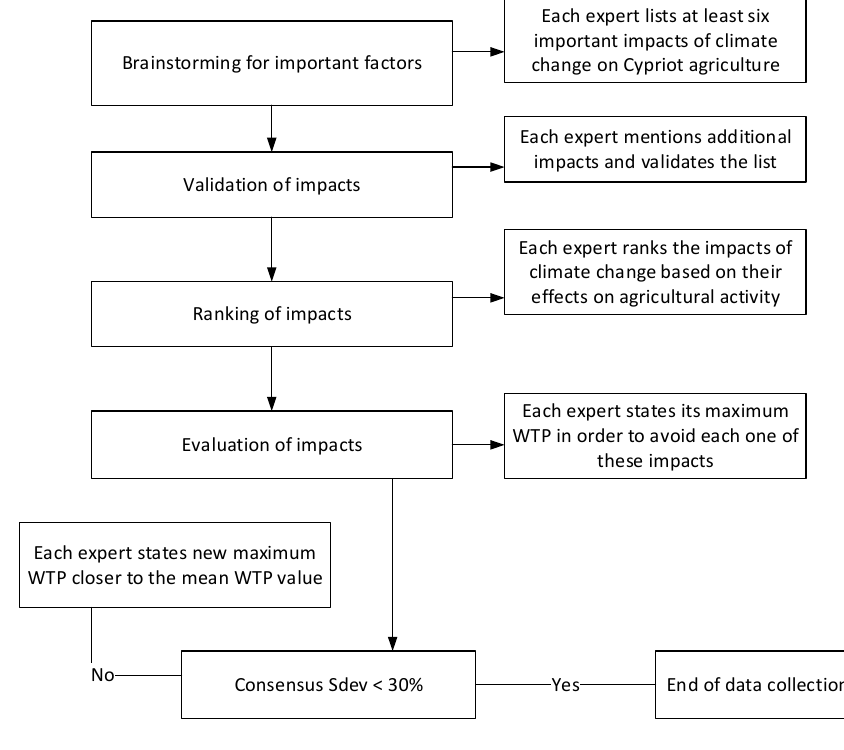
Figure 2. Data collection process.